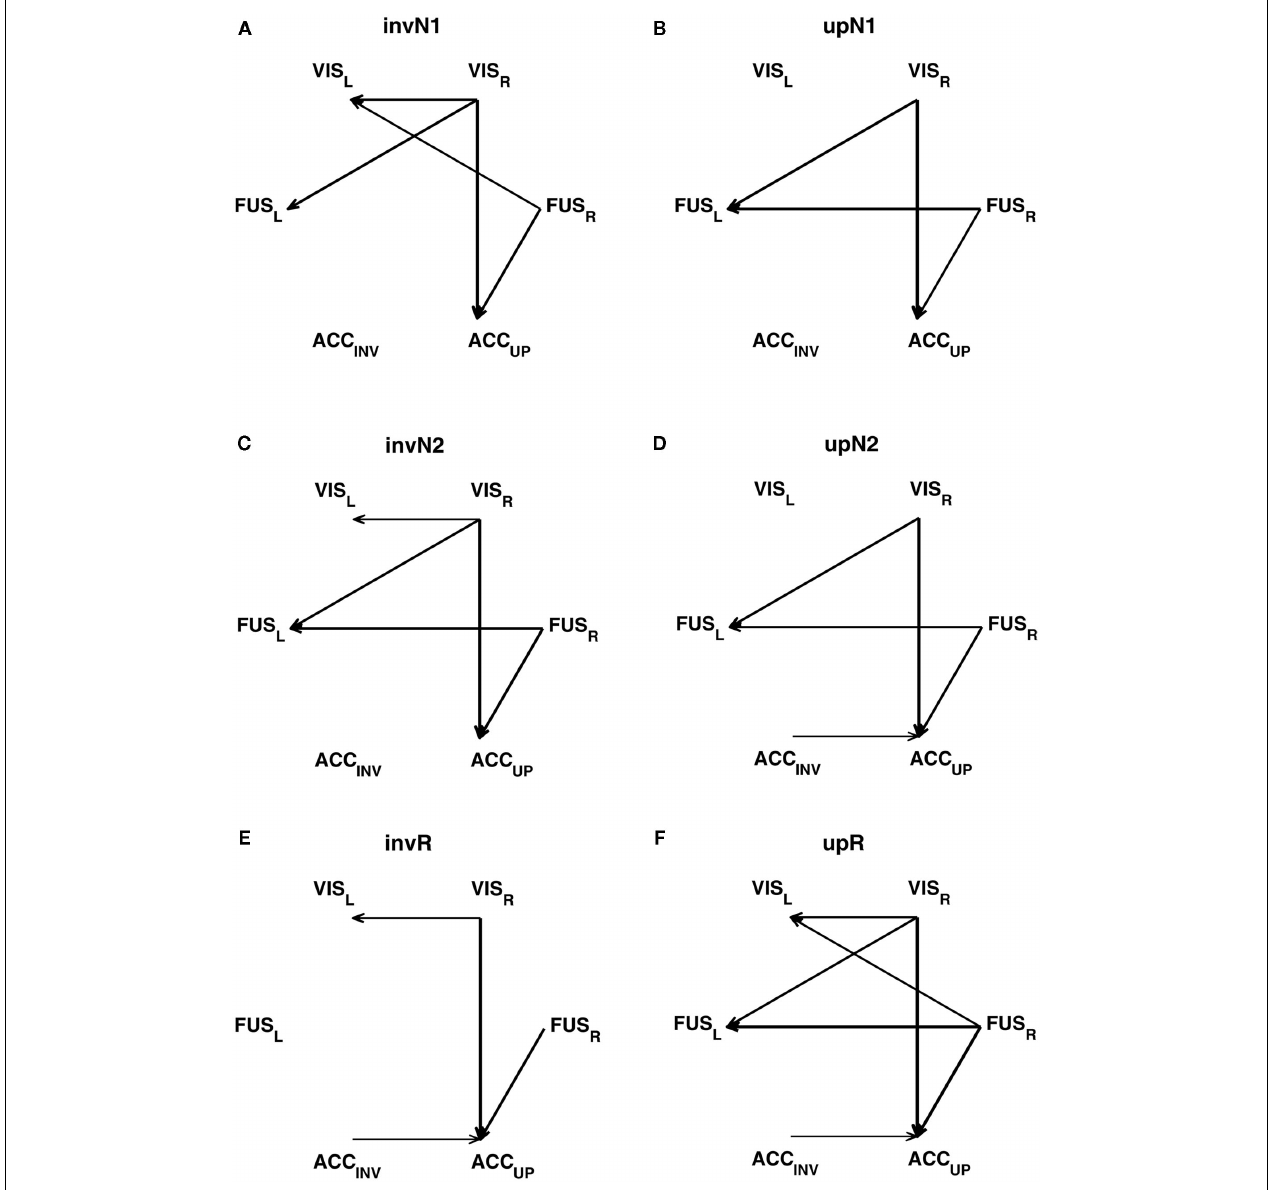
by the bootstrap maps, using the bootstrap ratio threshold of 3.0, corresponding roughly to a 95% confidence interval.The arrow’s width is related to the bootstrap ratio value associated with a given